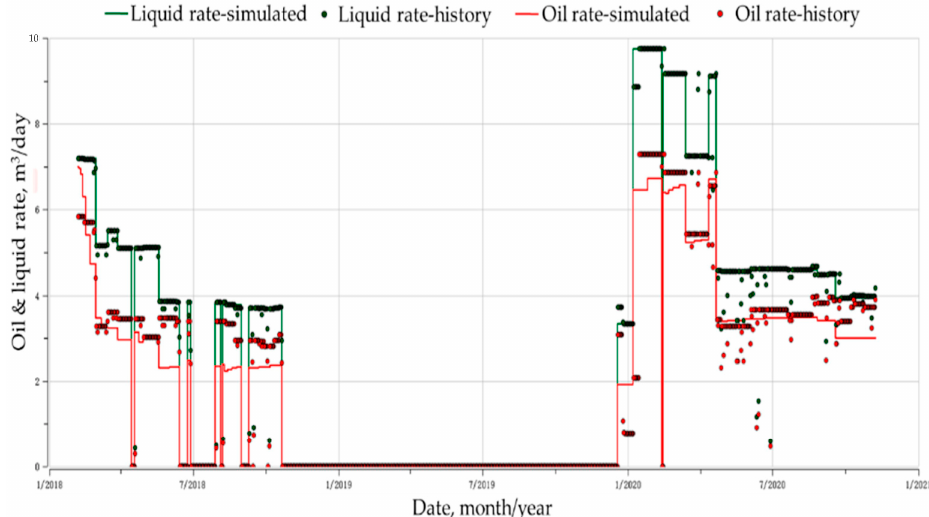
Figure 11. History matching curves of the liquid rate and oil rate.